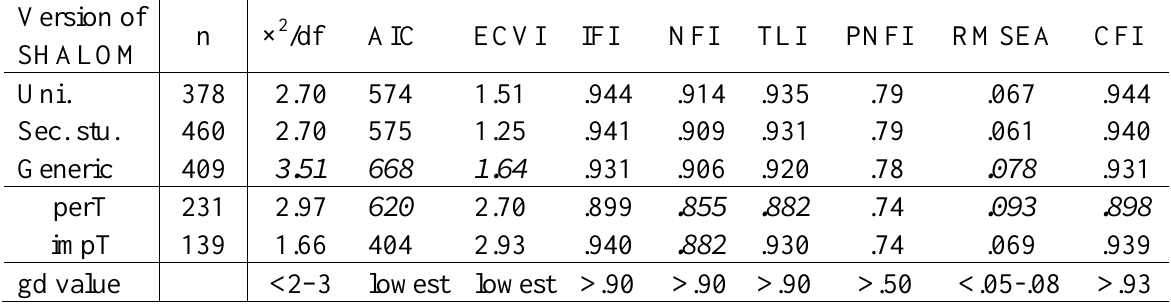
Table 3. Summary results for confirmatory factor analyses of versions of